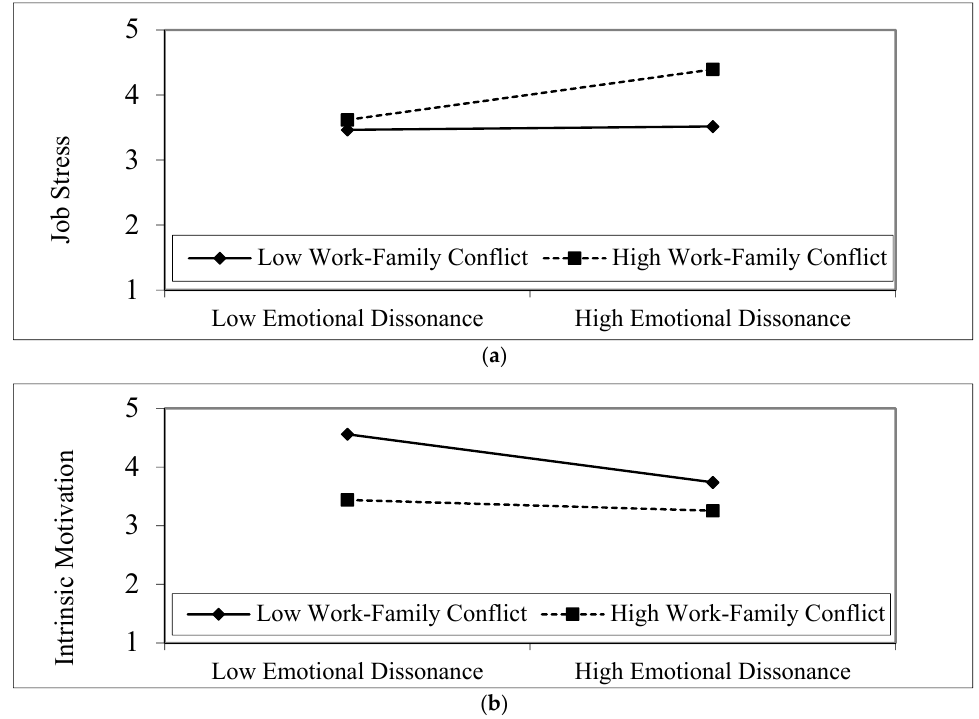
Figure 3. ( a ) The moderating effects of work–family conflict on job stress. ( b ) The moderating effects of work–family conflict on intrinsic motivation.